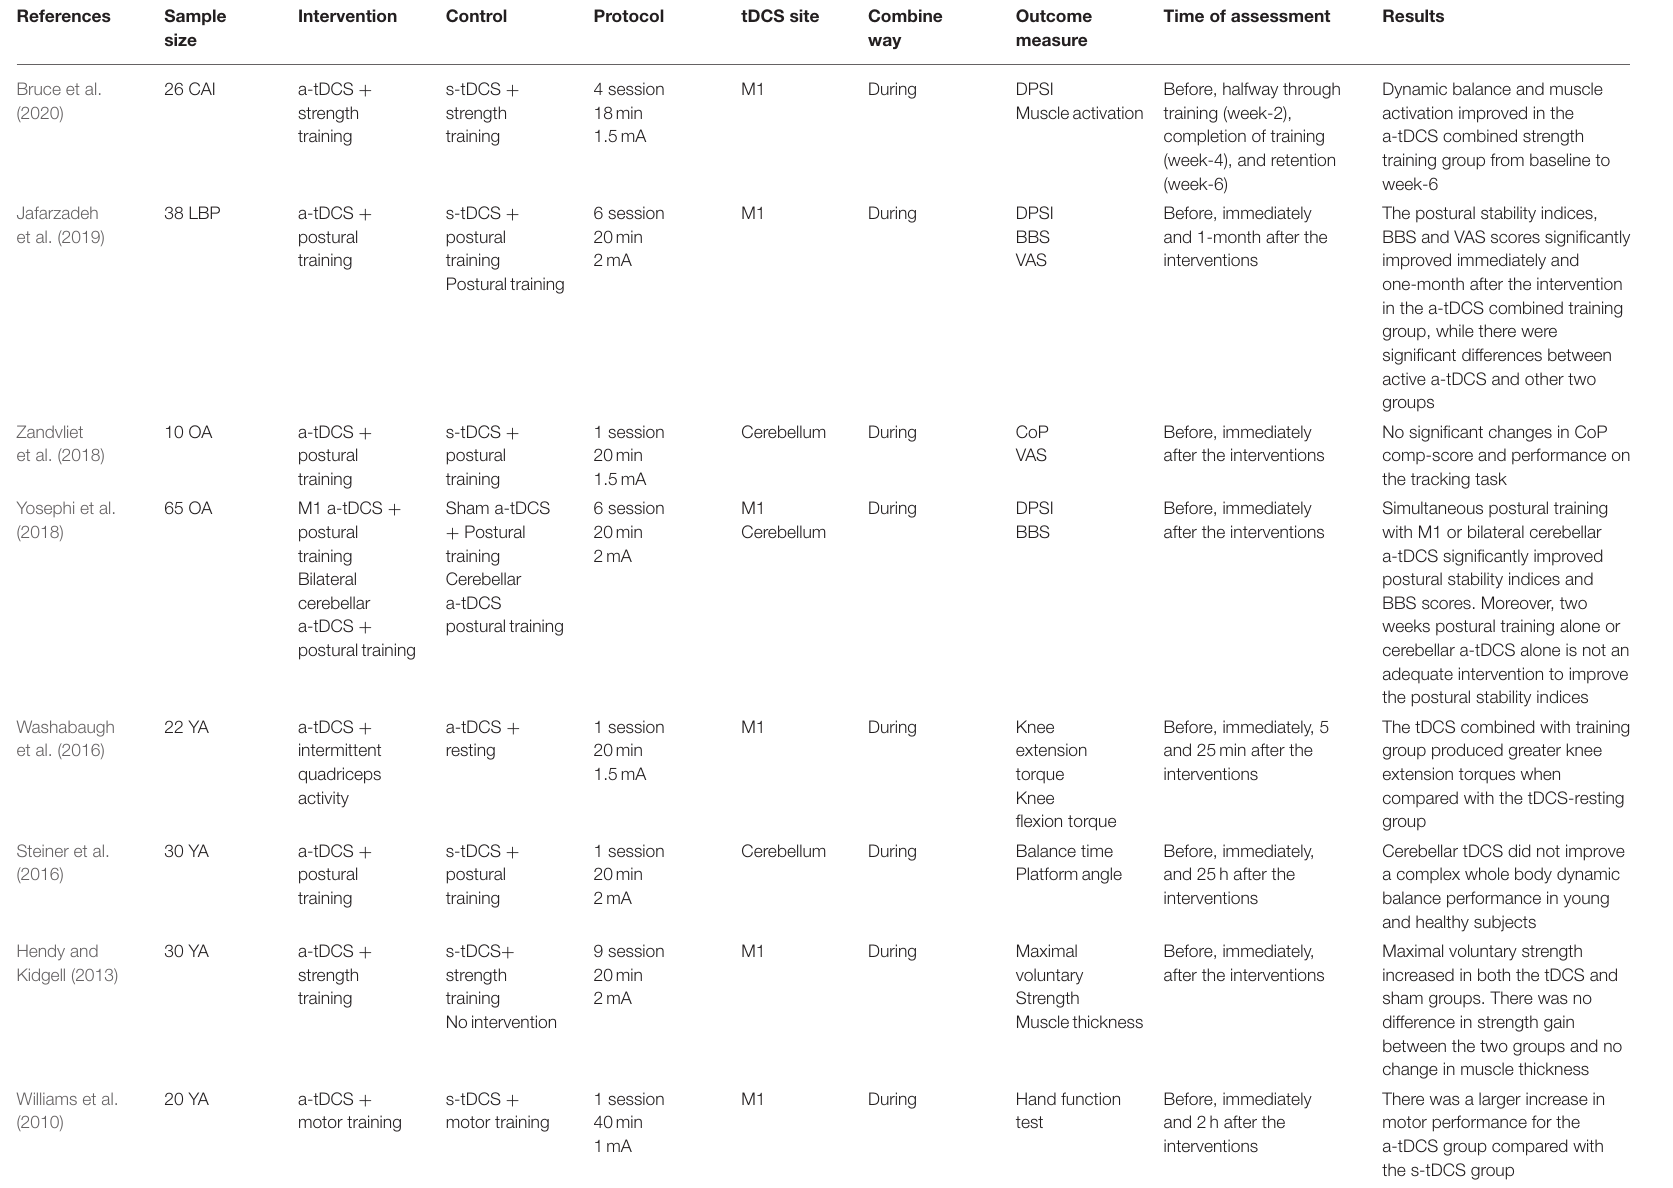
TABLE 2 | The effects of tDCS combined with physical training on physical